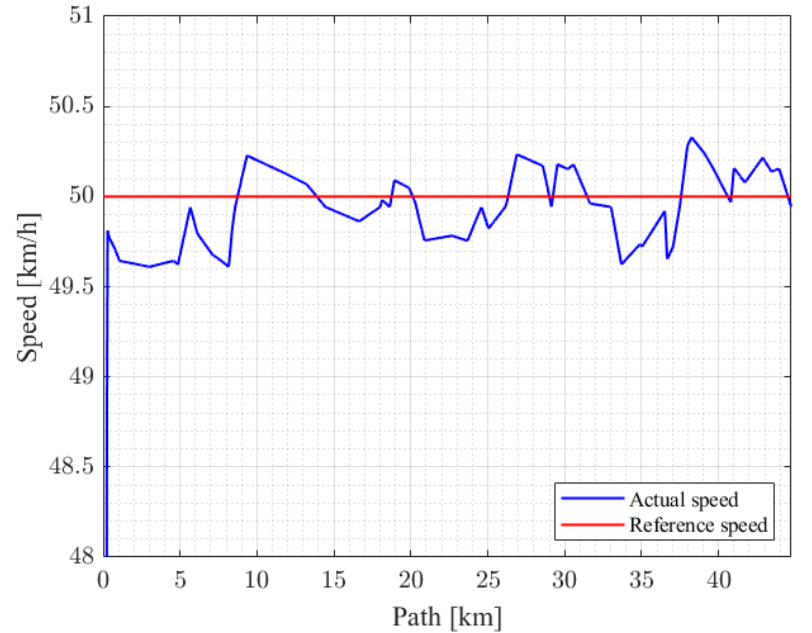
Figure 11. Comparison between the reference speed and the actual vehicle speed computed by the proposed